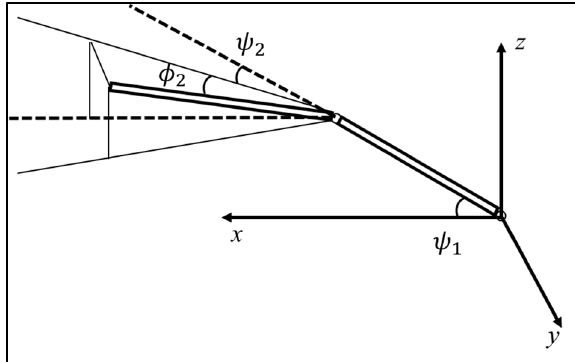
Figure 3. Kinematic model of a seagull’s wing.